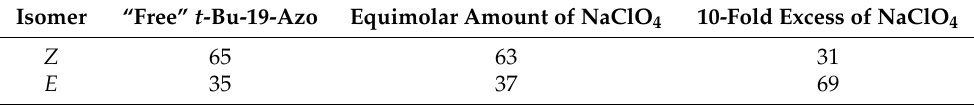
Table 3. The ratio (given as % of content) of Z and E isomers of t -Bu-19-Azo in acetonitrile solution and its change upon metal complex formation (estimated on the basis of 1 H NMR experiment in acetonitrile- d 3 ). Isomer “Free” t -Bu-19-Azo Equimolar Amount of NaClO 4 10-Fold Excess of NaClO